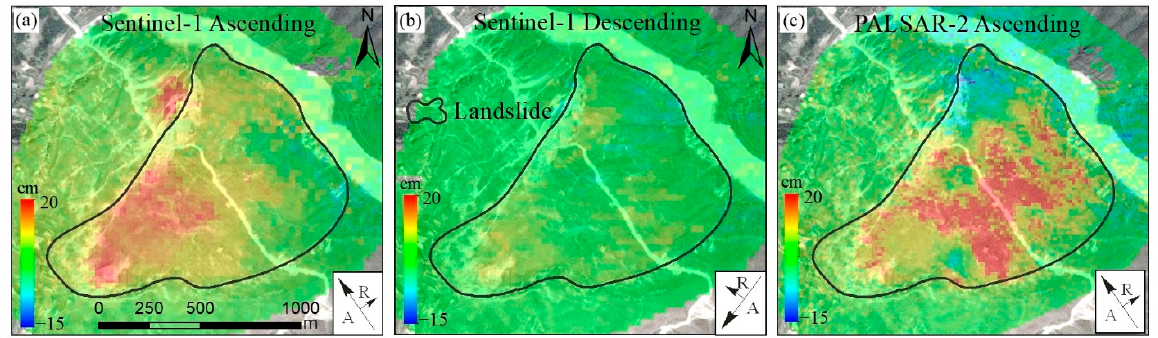
Figure 6. LOS accumulative deformation from the InSAR method; ( a – c ) are deformation results acquired from Sentinel-1 ascending, descending, and PALSAR-2 ascending data.